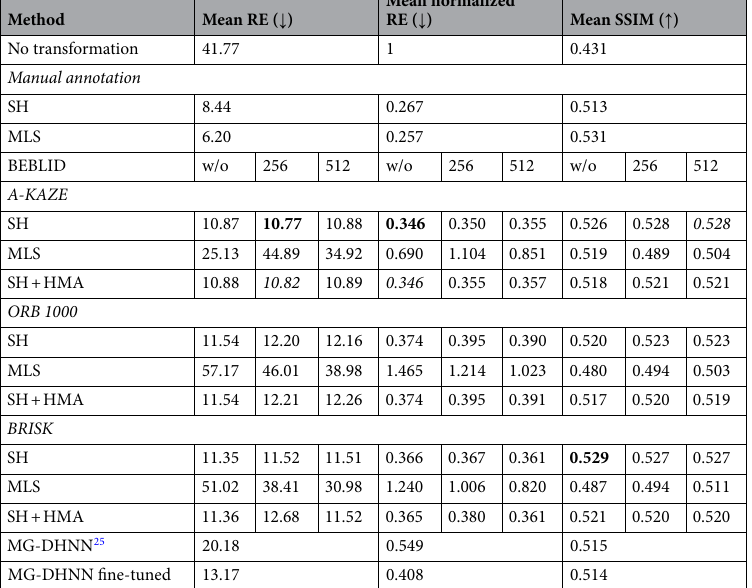
39% compared to the single homography for A-KAZE and BRISK respectively, the improvement for the entire image was marginal. All three feature-detector-descriptor algorithms gave higher errors for the MLS method, only A-KAZE and BRISK yielded a mean normalized RE below 1. Keypoint description with BEBLID 512 reduced the mean nor- malized RE for ORB1000 and BRISK in combination with MLS by 30% and 34% respectively. The MG-DHNN methods resulted in higher mean RE compared to the algorithms based on SH but per- formed better than the MLS methods. Fine-tuning of the MG-DHNN reduced the mean RE by 35%, however, SSIM was not improved. Mean SSIM was similar for all methods, with the lowest value for the identity homography (0.431) and the highest for the SH calculated with BRISK (0.529), which even outperformed the SH based on manual annotation (0.513). The means of RE, normalized RE, and SSIM for all tested methods are given in Table 1. The registration results of start frame 20 with two exemplary frames, 220 and 430, obtained from SH (ORB1000 and A-KAZE) and the original MG-DHNN are shown in Fig. 4. Displacements between ground truth and estimated transformation are indicated with crosses. Despite a larger RE in frame 430 with ORB1000, all three methods gave similar results for both frames, even under tissue deformation and partial occlusion. For the comparison of the tested SH and MG-DHNN methods and the ground truth over consecutive frames, the mean normalized RE and SSIM of the first scene are plotted in Fig. 5. Additionally, the registration of start frame 20 with the subsequent frames based on SH and A-KAZE is available in Supplementary Video S4. A more detailed representation of the RE and the movement of each annotation is given in Supplementary Fig. S5 for ORB1000 and SH. In frames with small tissue deformation, the original MG-DHNN shows similar or better results compared with the SH methods. However, if the tissue deformation is stronger, the mean normalized RE is greater than 1 and SSIM is even lower than without transformation. This was not obtained for the SH methods, but the MLS with ORB1000 and BRISK. The fine-tuned MG-DHNN performed much better than the original MG-DHNN in frames with strong tissue deformation, but SH methods were more robust. ORB1000 was the fastest feature-detector-descriptor with 22 ms (± 0.3 ms) for preprocessing, detection, and description, followed by A-KAZE and BRISK with 66 ms (± 2 ms) and 102 ms (± 2.6 ms) respectively. Feature matching was performed in 8 ms (± 0.1 ms) for ORB1000, 52 ms (± 5 ms) for A-KAZE, and 80 ms (± 7.9 ms) for BRISK features. Estimating a single homography was faster than the HMA or MLS method for all three feature- detector-descriptor algorithms. Processing a frame faster than 50 ms (20 fps) was only possible for the estima- tion of a single homography with ORB1000 (43 ms ± 5.8 ms). Transforming an image with the MG-DHNN was performed in 580 ms (± 11.4 ms). The mean normalized RE and mean processing times are shown in Fig. 6 for each tested transformation method using the respective BEBLID setting resulting in the lowest normalized RE. Qualitative results with HSI data. The developed preprocessing and registration process enabled the augmentation of in-vivo laparoscopic video data with tissue oxygenation maps from HSI. Figure 7 shows the acquired image data and the resulting overlay of both modalities after perspective transformation with an SH found with ORB1000 based on the start and target frame of the video. Regions with an intensity difference higher than the error threshold were excluded from the overlay during postprocessing. This prevents misleading